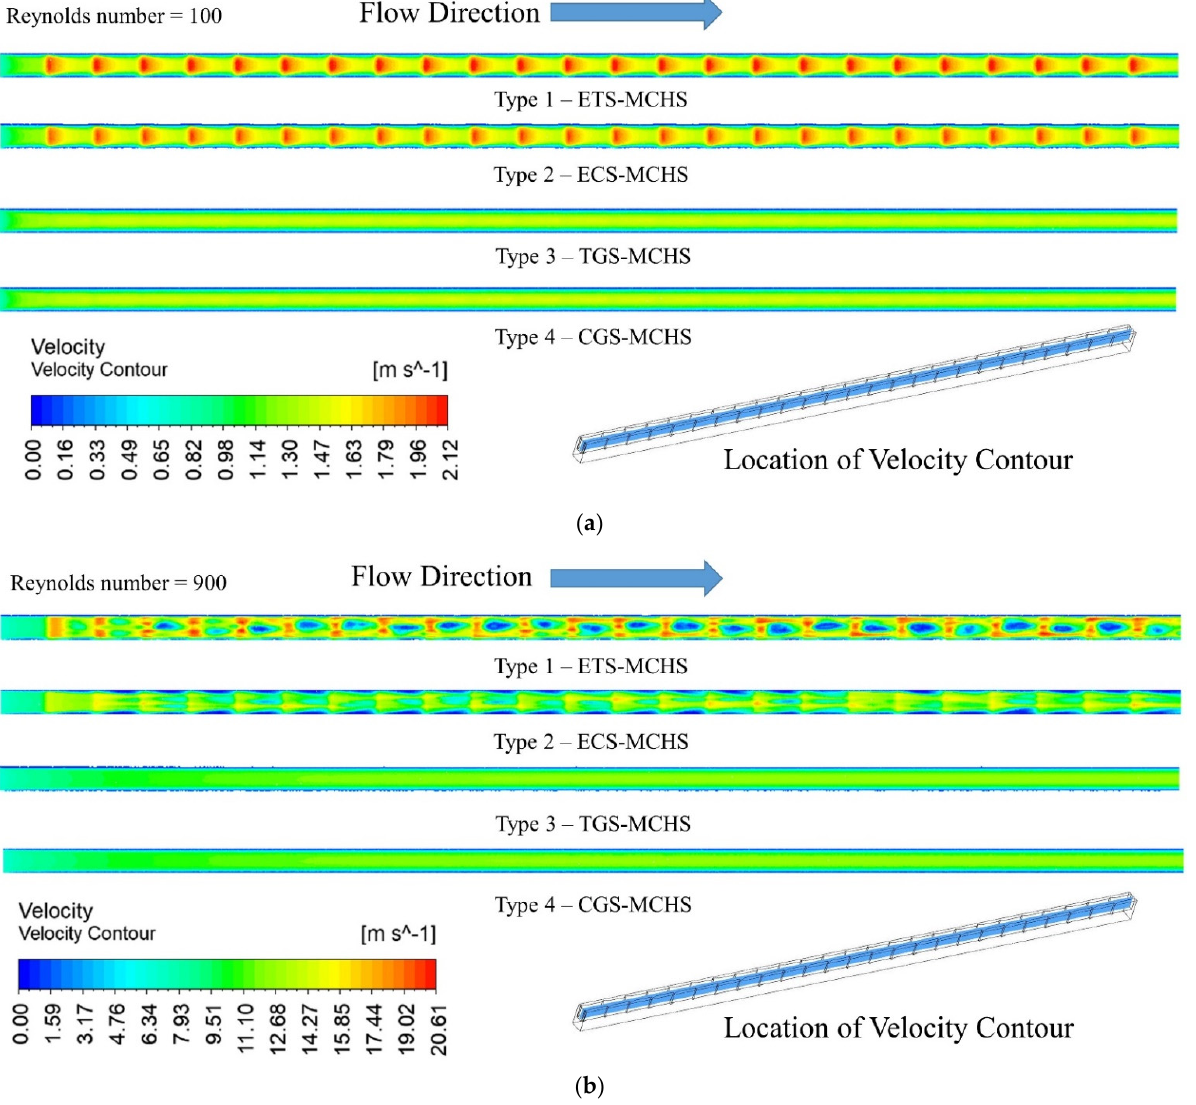
Figure 5. Velocity contour of heat transfer fluid at mid plane of fluid domain for ( a ) Re = 100 and ( b ) Re = 900.